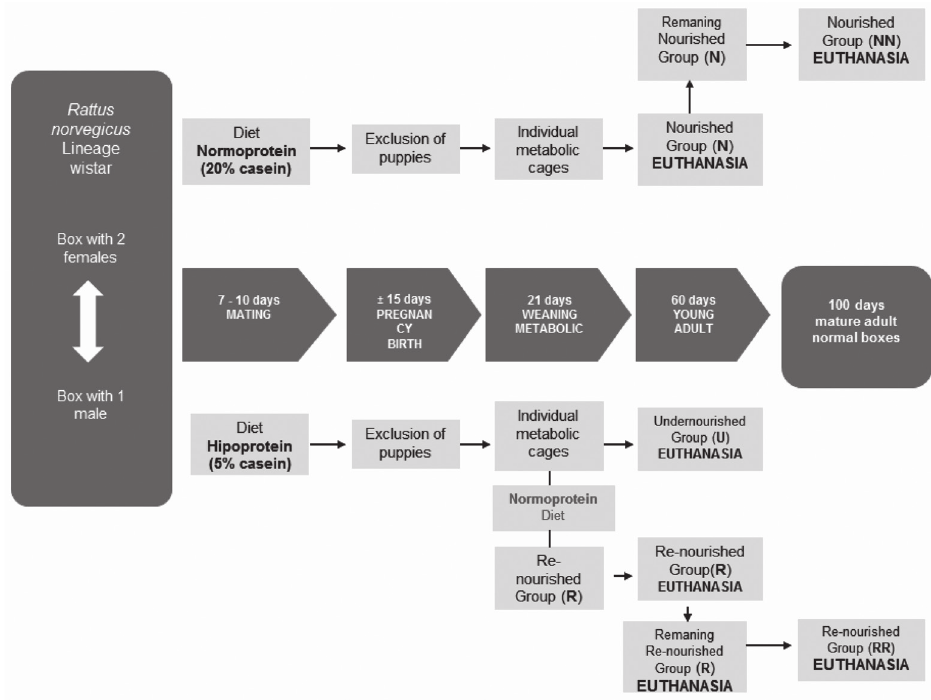
Figure 1- Schematic representation of experimental group